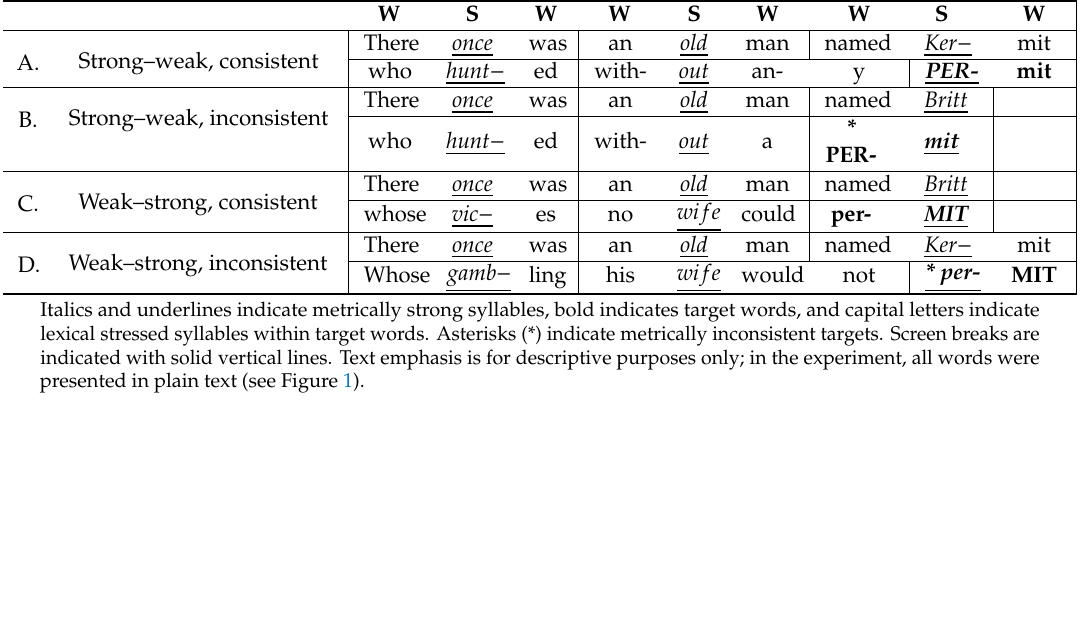
Table 1. Metric structure of experimental couplets in each of the four conditions for the target word ‘permit’. W